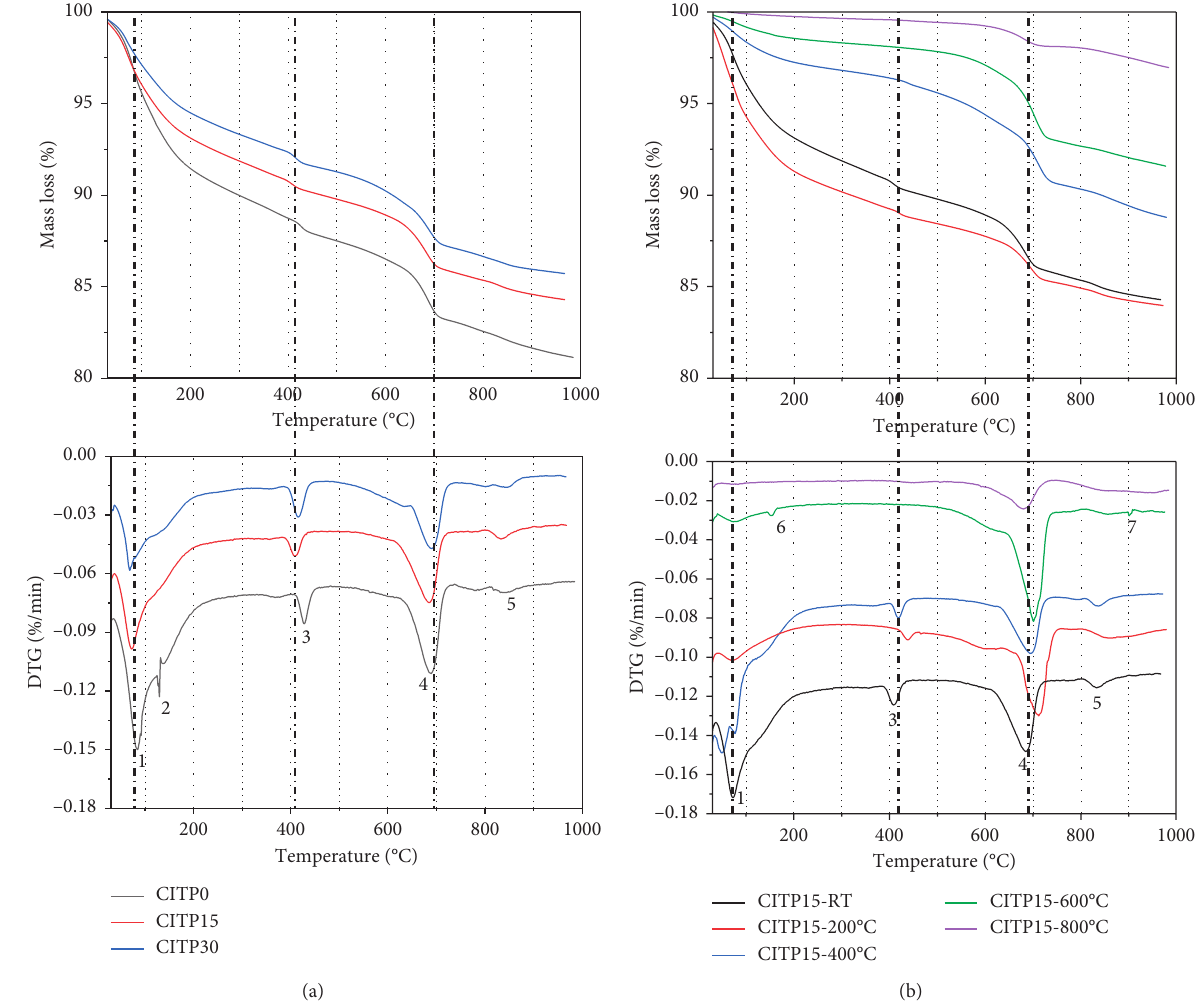
Figure 6: DTA curves and mass loss of concrete: (a) the reference sample CITP0, CITP15, and CITP30 at RT; (b) the CITP15 exposed to high